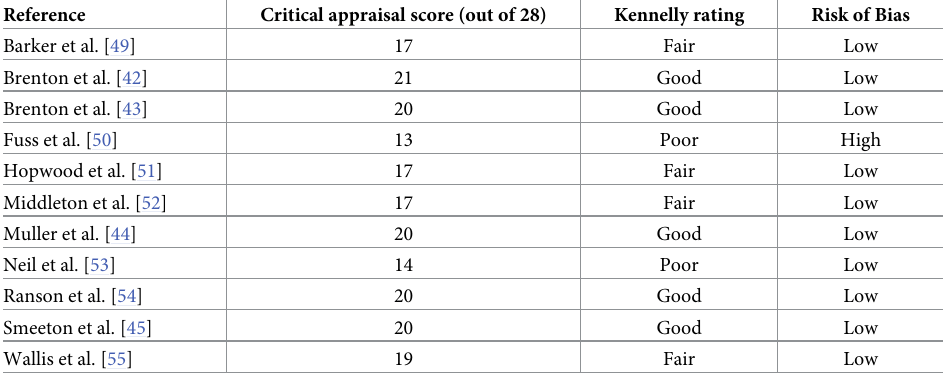
Table 2. Critical appraisal of studies for quality assessment and risk of